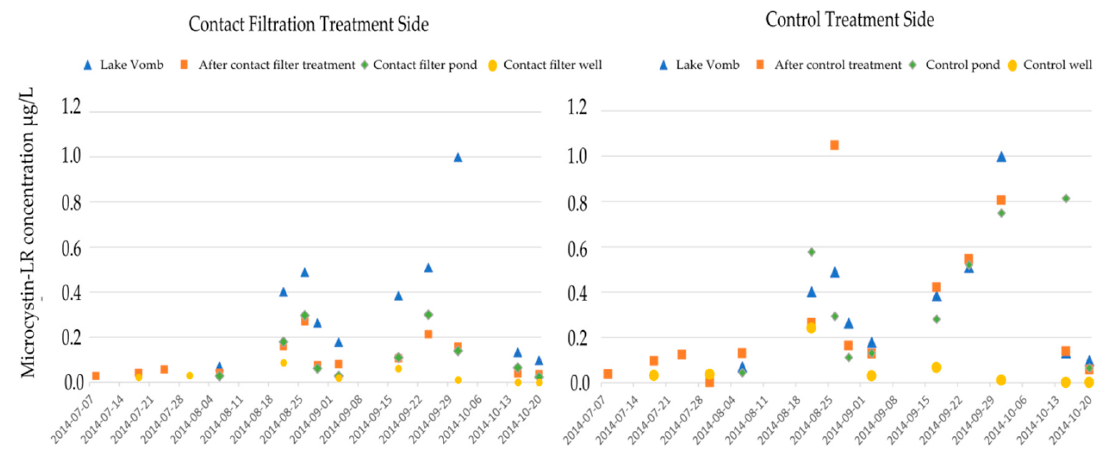
Figure 8. Microcystin development along the sampling period (left is the microcystin condition in the contact filtration treatment process and right is the control